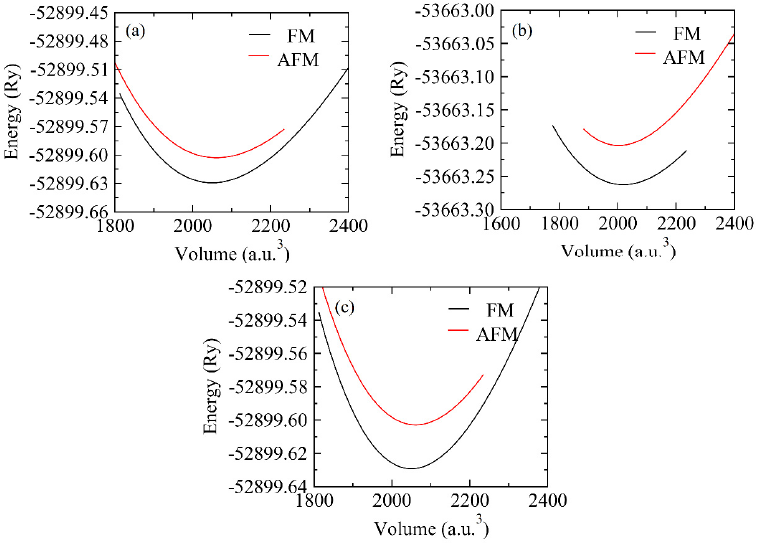
Figure 2. The optimization plots of ( a ) ZnTi 2 Se 4 , ( b ) ZnV 2 Se 4 , ( c ) ZnCr 2 Se 4 in antiferromagnetic (AFM) and ferromagnetic (FM) phases.